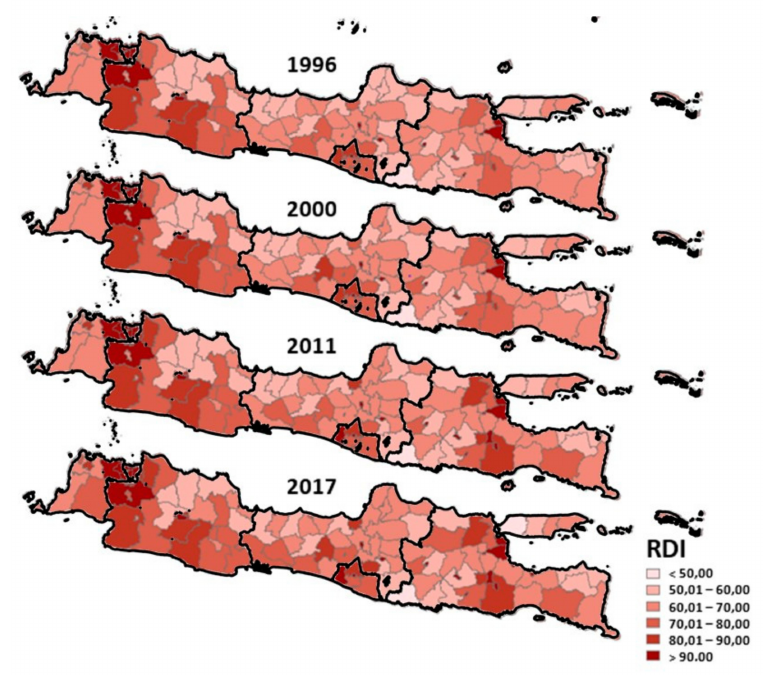
Figure 1. Spatiotemporal distribution pattern of RDI of